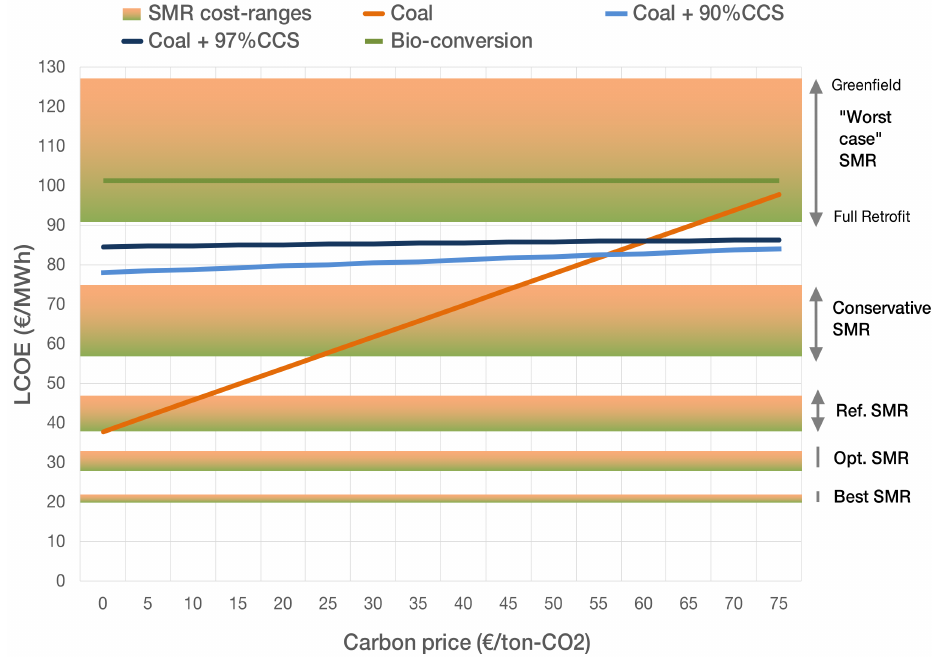
Figure 11. Rough indicative LCOE comparison of firm dispatchable power alternatives in